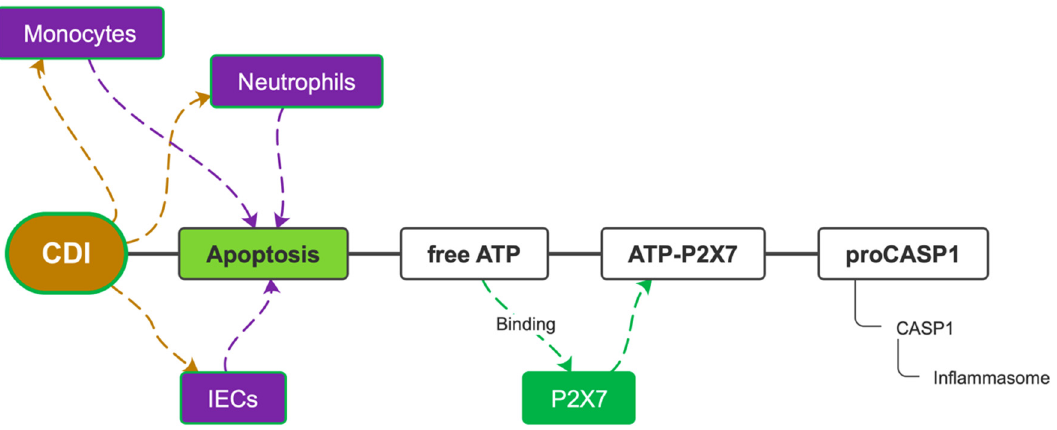
Figure 5. The ATP-P2X7 pathway. CDI = C. difficile infection; IECs = intestinal epithelial cells; ATP = adenosine triphosphate; P2X7 = purinergic receptor 2X7; pro-CASP1 = pro-caspase-1; CASP1 = caspase-1.